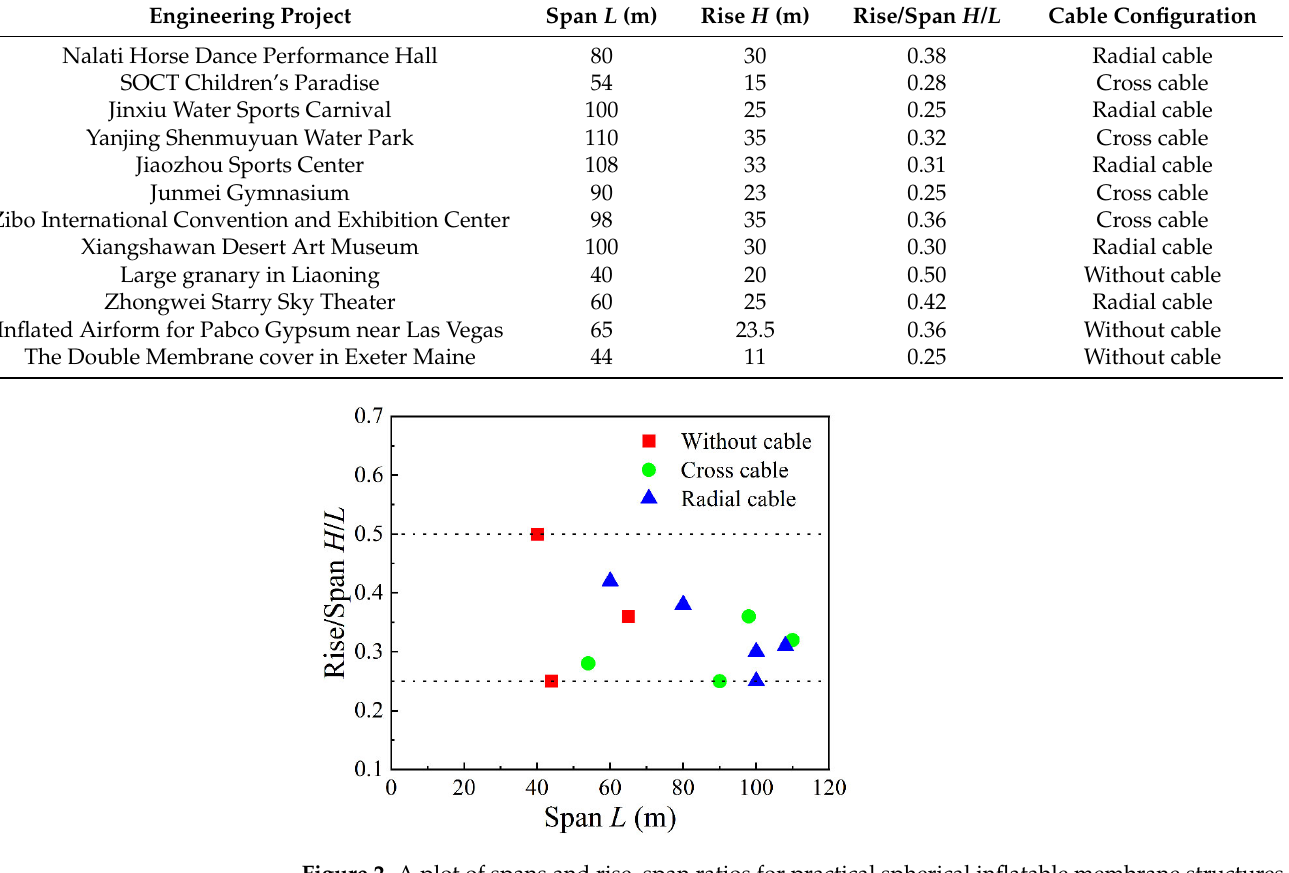
Figure 2. A plot of spans and rise–span ratios for practical spherical inflatable membrane structures displayed in Table